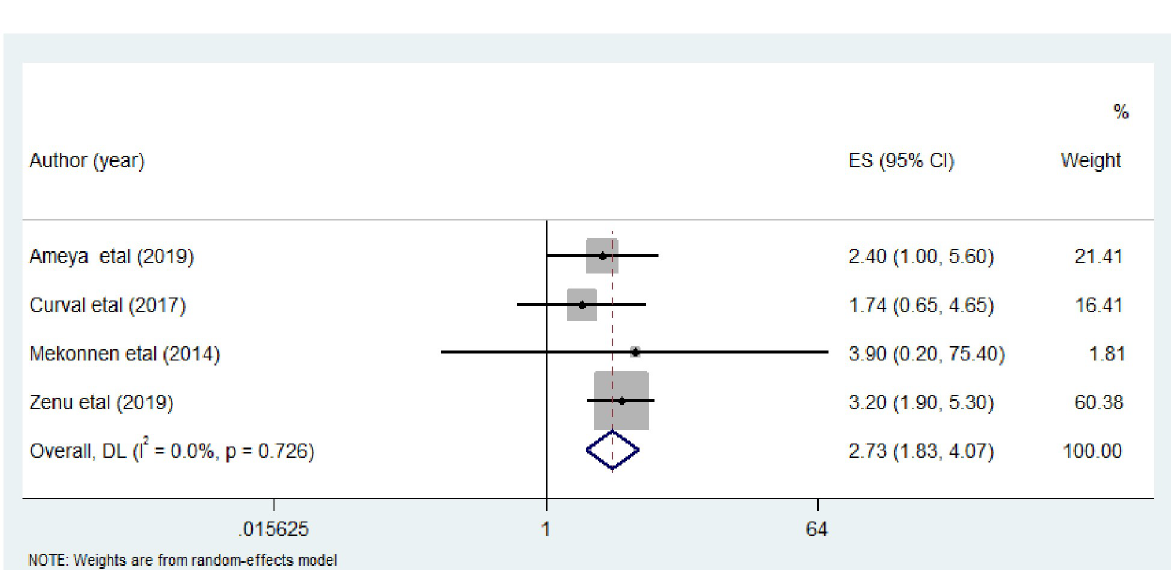
Fig 6. The pooled odds ratio of the association between hand washing habit and intestinal parasitic infection among street dwellers and prison inmates.